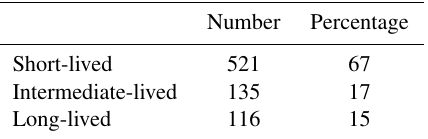
Table 1. Categories of wave packets from the 775